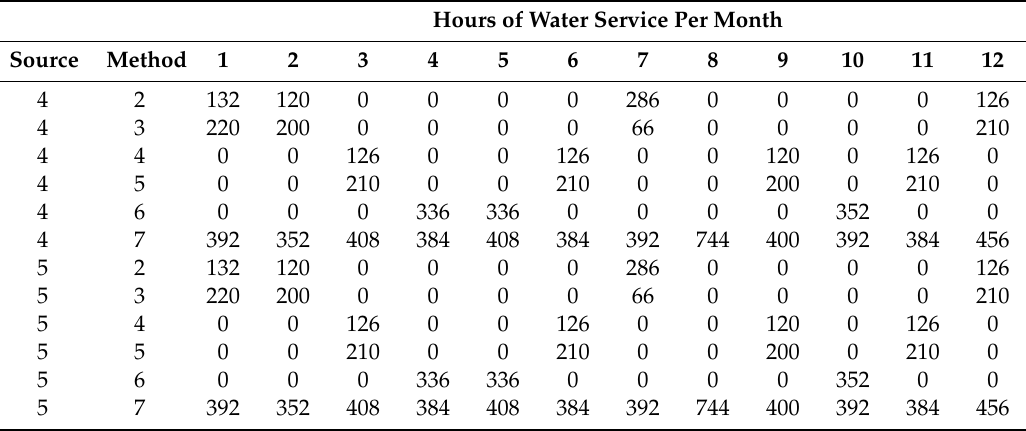
Table 5. Limitation of hours for supplying water for Sources 4 and 5.